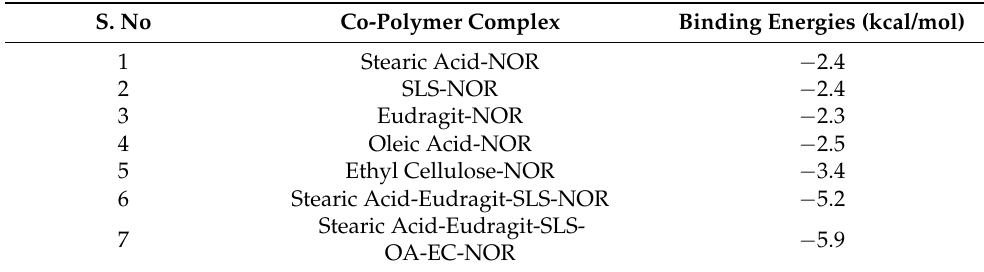
Table 8. Binding energies calculations for different Co-polymeric systems of SLS, Eudragit, HPMC and NOR.